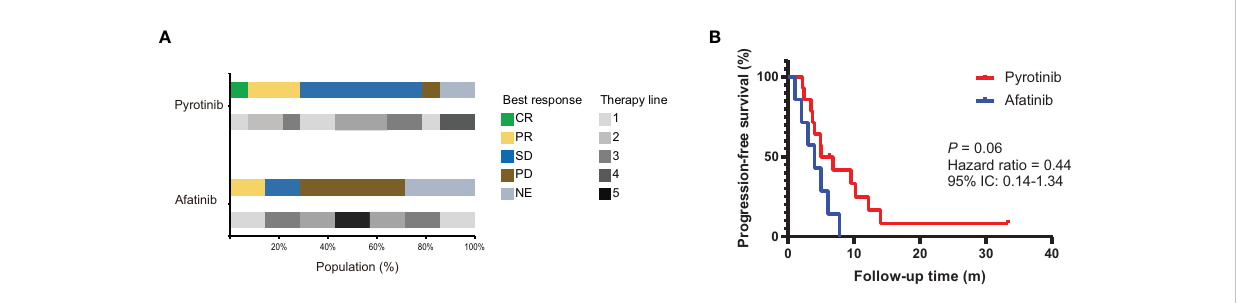
FIGURE 3 The ef fi cacy of afatinib and pyrotinib in NSCLC patients with HER2 alterations. (A) The proportion of best clinical response and therapy line for HER2 -altered NSCLC patients treated with afatinib ( n = 7) or pyrotinib ( n = 14). (B) Kaplan – Meier estimates of progression-free survival of HER2 - altered NSCLC patients treated with afatinib or pyrotinib.